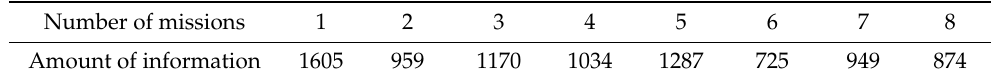
Table 3. Degree of nodes in each layer of the